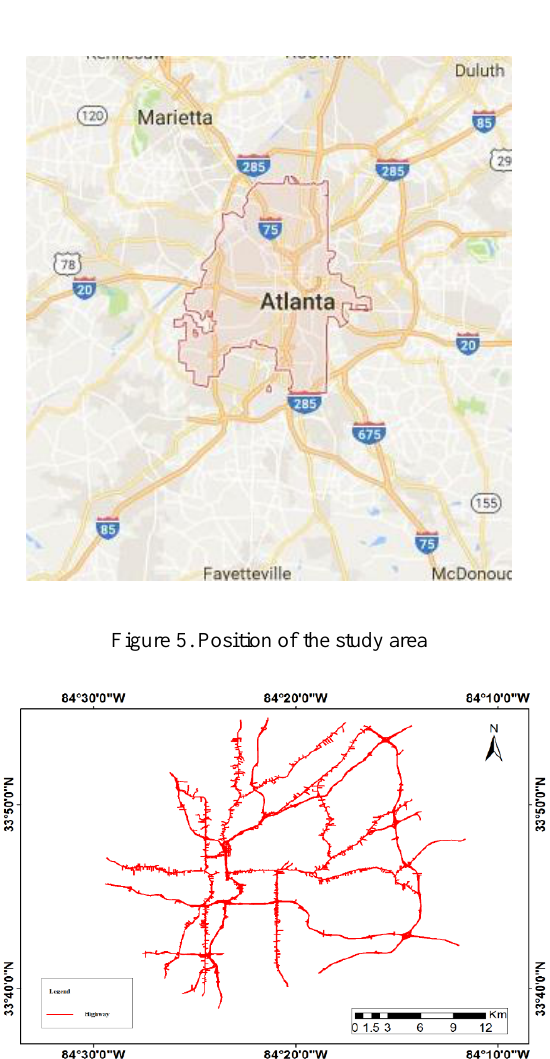
Figure 6. Current situation of highways